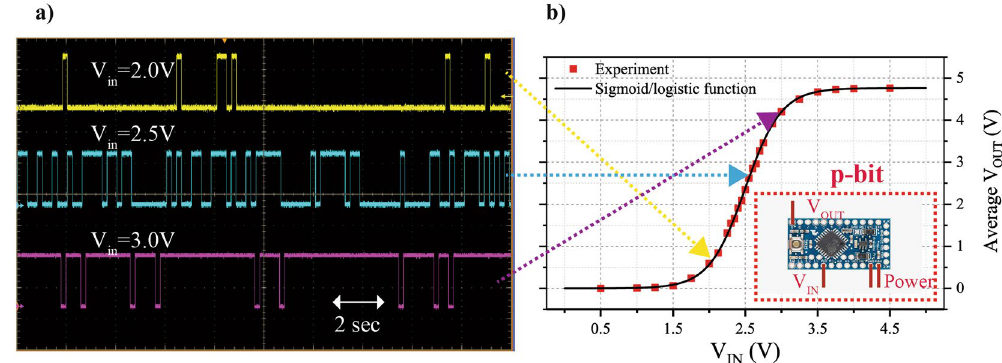
Figure 1. p-bit emulated using Arduino microcontroller. Eq. (1) is emulated using the Arduino mini pro microcontroller as detailed in Algorithm 1. The microcontroller shown in the inset of ( b ) has dedicated analog input and digital output pins. The time evolution of the output voltages of p-bits is shown in ( a ) using a Tektronix DPO7104 oscilloscope. The p-bits produce more 1’s than 0’s as the input voltage is increased, demonstrating the tunable nature of the p-bit. Each of the red markers shown in ( b ) is a DC average measurement taken for a 100 second interval of the output voltage for a given input voltage. The average output voltages follows the sigmoidal function of Eq. (4).